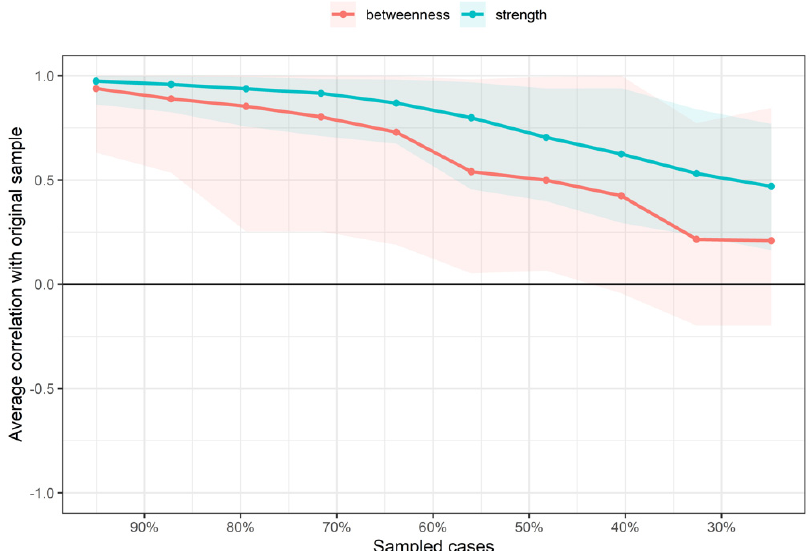
Figure 3. Average correlations between centrality indices of networks sampled with persons dropped and networks built on the entire input dataset, at all follow ‐ up time points. Lines indicate and networks built on the entire input dataset, at all follow-up time points. Lines indicate the means the means and areas indicate the range from the 2.5th quantile to the 97.5th quantile. and areas indicate the range from the 2.5th quantile to the 97.5th